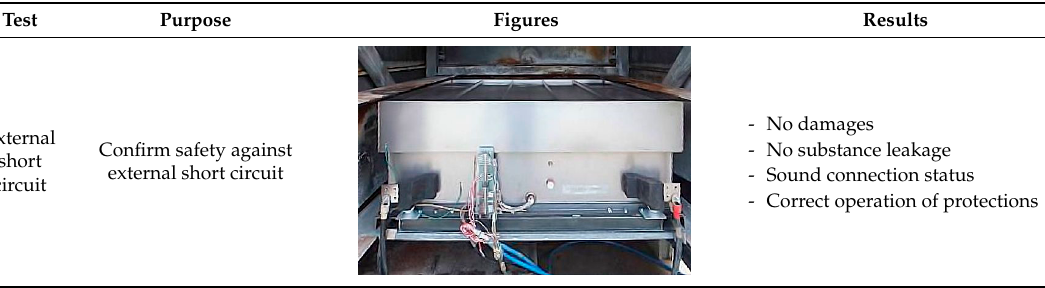
Table 2. Safety Tests performed by NGK on the new module.